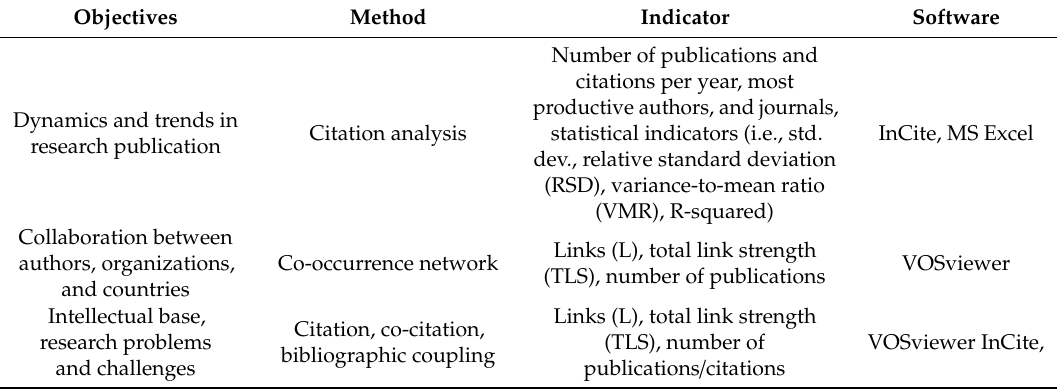
Table 2. Research objectives, methods, bibliometric indicators, and